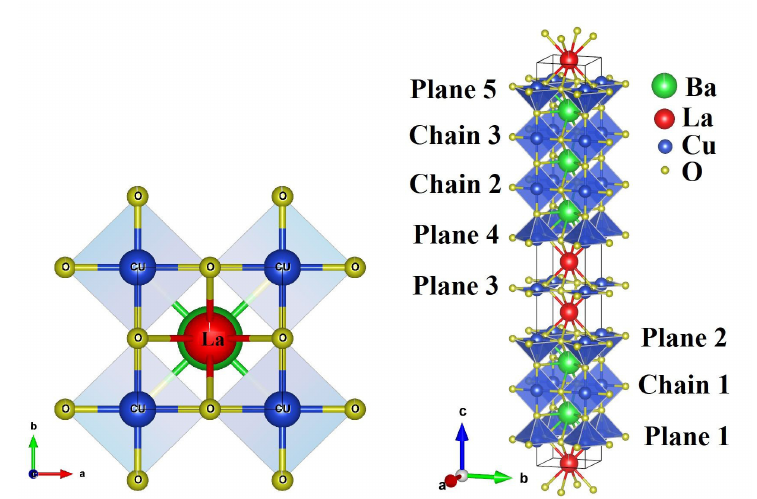
Ba Cu O sample obtained by combustion method. 3 5 8 18-δ